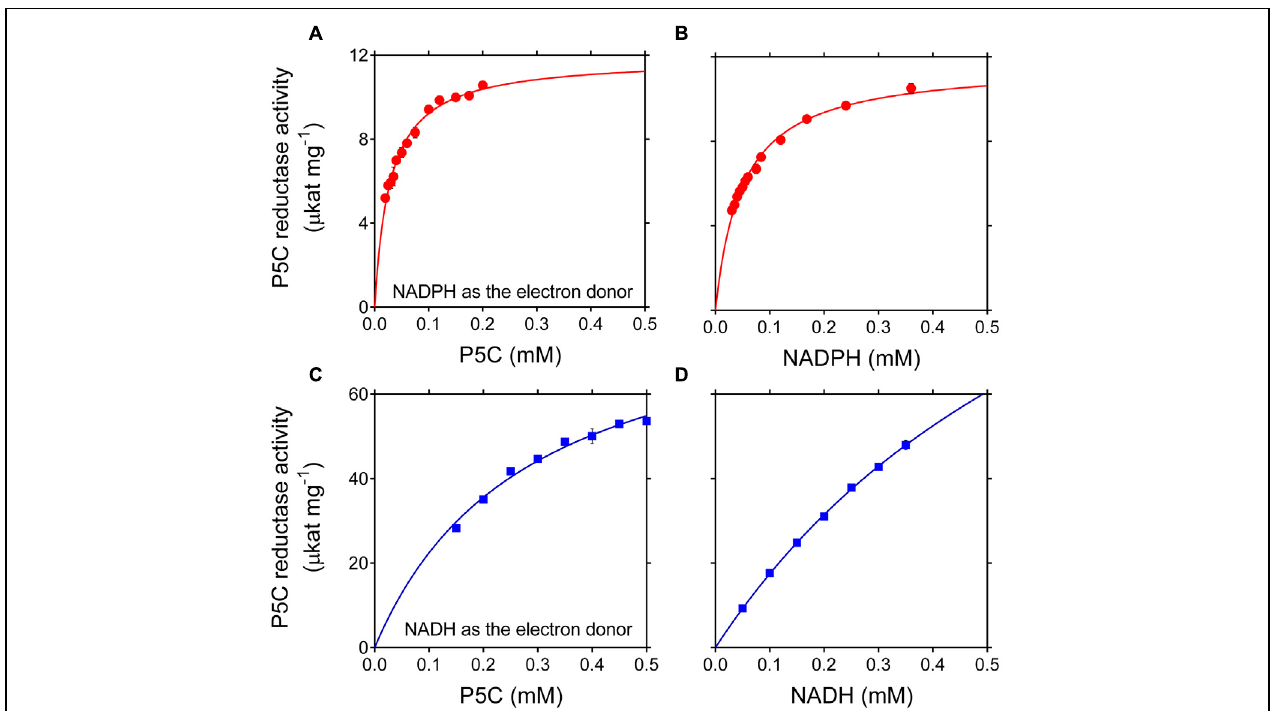
FIGURE 1 | Effect of substrate concentration on the activity of rice P5C reductase. The activity of purified recombinant rice enzyme (8 ng) was measured for up to 5 min at 35 ◦ C in the presence of increasing concentrations of L -P5C (A,C) , NADPH (B), or NADH (D) . Invariable substrates were fixed at the same levels as in the standard assay. At least